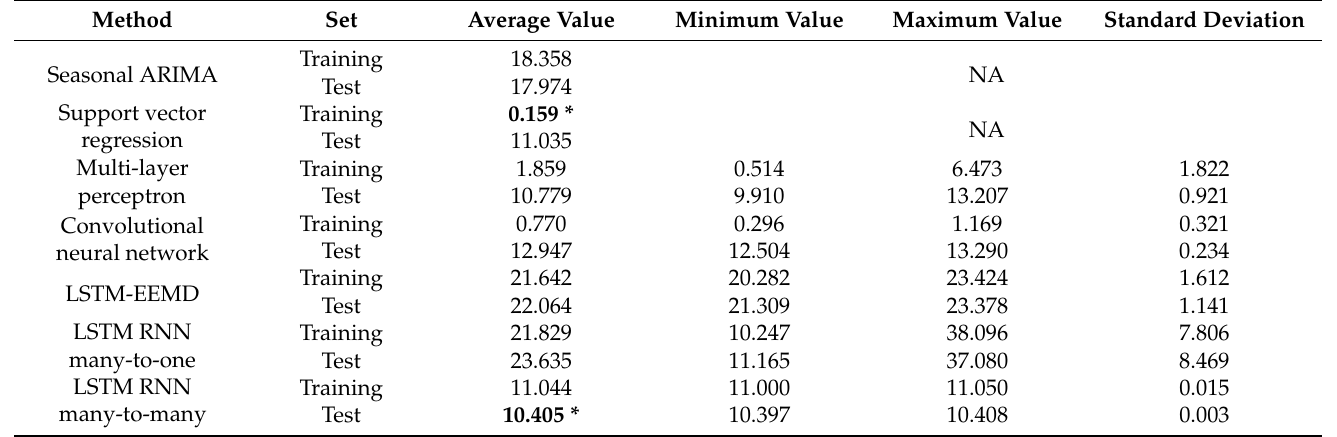
Table 7. Root mean square error for artificial dataset.